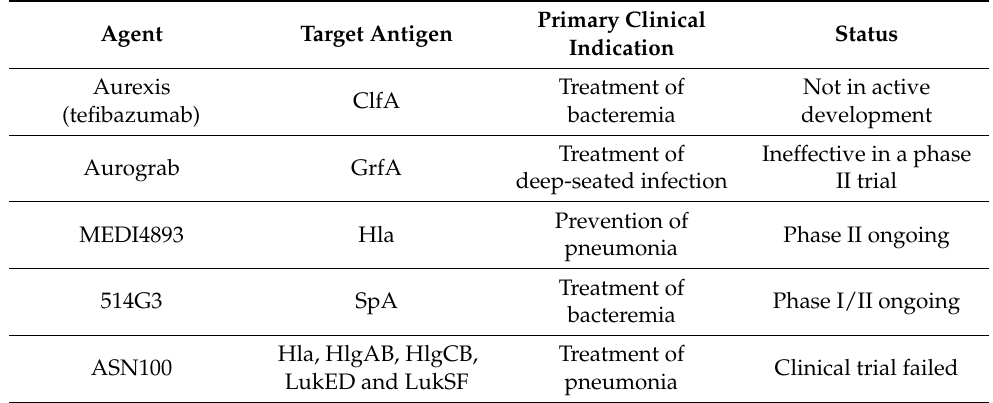
Table 2. Efficacy of mAbs against S. aureus in clinical